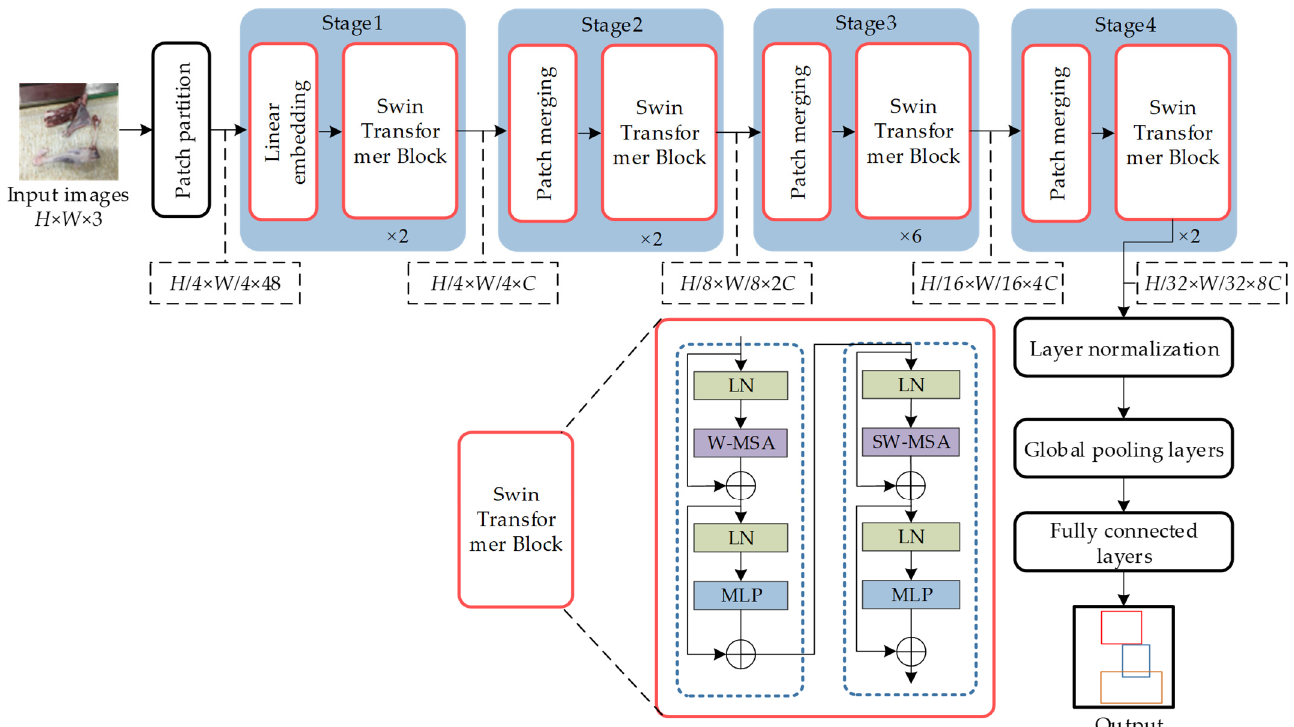
Figure 4. Swin-Transformer network structure. Note: H is the height of the input image, pixels; W is the width of the input image, pixels; C is the dimension of feature graph; LN is the Layer Norm; W-MSA is the Window Multi-head Self-A tt ention structure; SW-MSA is the Shifted Window Muti-head Self-A tt ention structure; MLP is Multilayer Perceptron; Stage1-Stage4 is cascading modules.